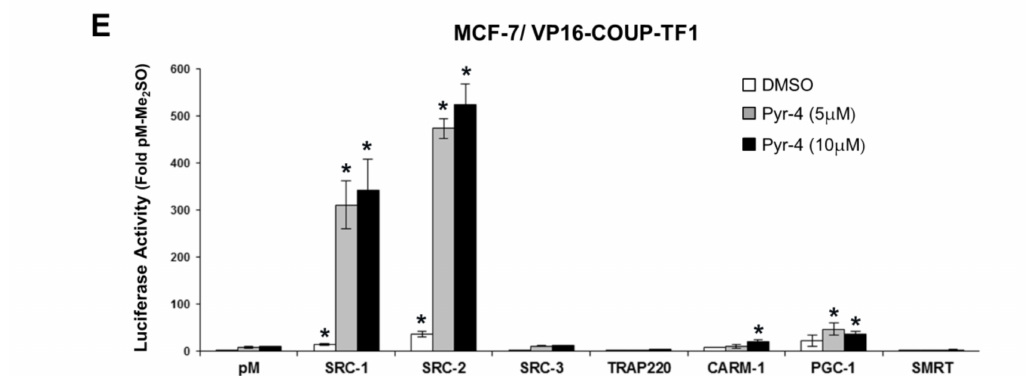
Figure 1. Heteroaromatic methylene substituted diindolylmethanes (C-DIMs) activate Chicken ovalbumin upstream promoter-transcription factor I (COUP-TFI) and induce COUP-TFI-coactivator interactions. Activation of GAL4-COUP-TFI in MCF-7 ( A , C , D ) and ZR-75 ( B ) cells by heteroaromatic C-DIMs. Cells were transfected with GAL4-COUP-TFI and GAL4-luc constructs treated with Me 2 SO (control) or different concentrations of heteroaromatic C-DIMs, and luciferase activity (relative to β -galactosidase activity) was determined as described in the Materials and Methods section. Results are means ± SE for three replicate determinations for each treatment group and significant ( p < 0.05) induction is indicated by an asterisk. ( E ) Mammalian two-hybrid assay. MCF-7 cells were transfected with VP-COUP-TFI/GAL4-luc and chimeric GAL4-coactivator constructs, treated with Me 2 SO, 10 or 15 µ M 1,1-bis(3 (cid:48) -indolyl)-1-(4-pyridyl)-methane (DIM-C-Pyr-4), and luciferase activity determined